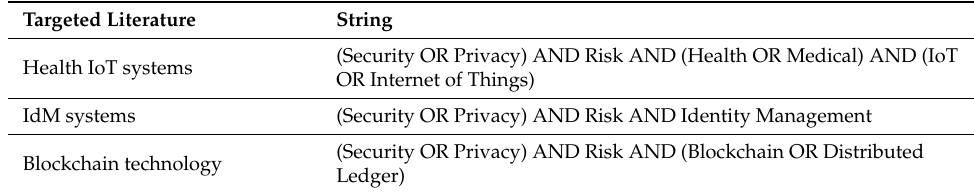
Table 4. The strings used in the search process.